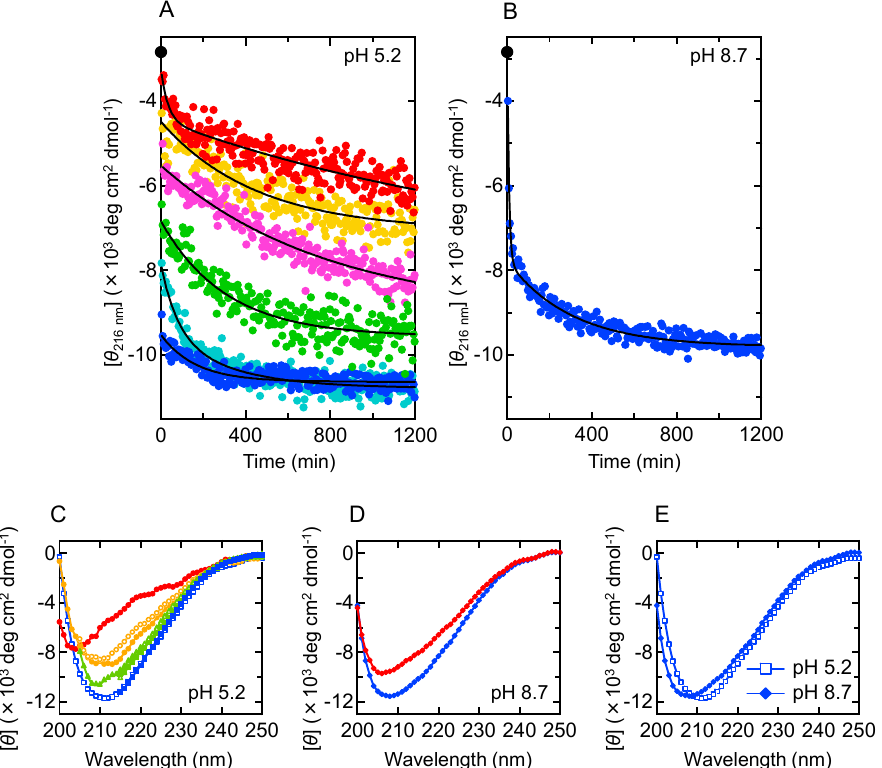
Figure 4. Difference in the formation process of prefibrillar aggregates between pH 5.2 and pH 8.7 as revealed by CD spectral changes. ( A ) Time-dependent changes in the values of mean residue molar ellipticity at 216 nm [ θ 216 nm ] at pH 5.2. Plots at six different peptide concentrations (0.22 mg/mL, red; 0.25 mg/mL, orange; 0.30 mg/mL, magenta; 0.50 mg/mL, green; 0.70 mg/mL, cyan; 1.40 mg/mL, blue) are shown. Black lines represent regression curves obtained by fitting analysis with an exponential or a biexponential function, using Equation (1) (for 0.25 mg/mL, 0.30 mg/mL, 0.50 mg/mL, and 1.40 mg/mL) or Equation (2) (at 0.22 mg/mL and 0.70 mg/mL). A black circle indicates the value of the monomeric B chain measured in NaOH. ( B ) Time-dependent changes in the values of [ θ 216 nm ] at pH 8.7. Plots at a peptide concentration of 1.40 mg/mL are shown. A black line represents a regression curve obtained by spectral fitting using a biexponential function, Equation (2). A black circle indicates the value of the monomeric B chain. ( C ) CD spectra of intermediate states at pH 5.2 reproduced by spectral extrapolation at each phase in the spectral fitting. Overlaying spectra obtained at different peptide concentrations (closed circles, 0.22 mg/mL; open circles, 0.25 mg/mL; closed triangles, 0.30 mg/mL, open triangles, 0.50 mg/mL; closed squares, 0.70 mg/mL; open squares, 1.40 mg/mL) suggested four different states, which are colored by red, orange, green, and blue in order of appearance, respectively. ( D ) CD spectra of intermediate states at pH 8.7 reproduced by spectral extrapolation at each phase in the spectral fitting. The result suggested two different states, as shown by red and blue diamonds in order of appearance. ( E ) Comparison of final convergent spectra between the pH 5.2 and the pH 8.7 prefibrillar aggregates.